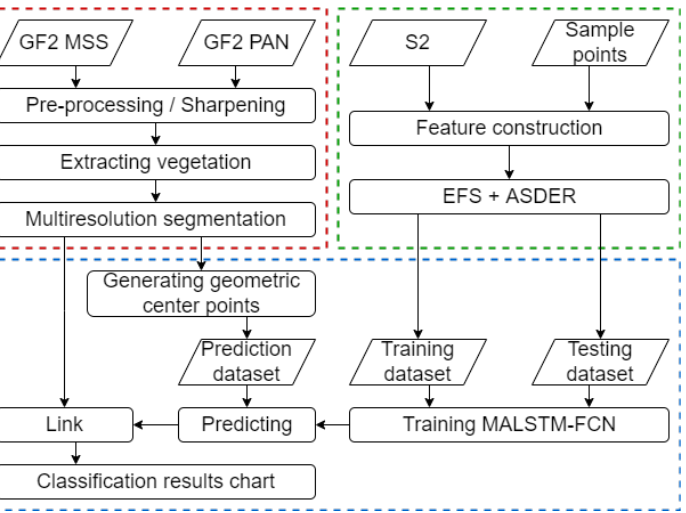
Figure 5. Technical flow diagram. The first part is in the red box, the second is in the green box, and the third is in the blue box. the third is in the blue